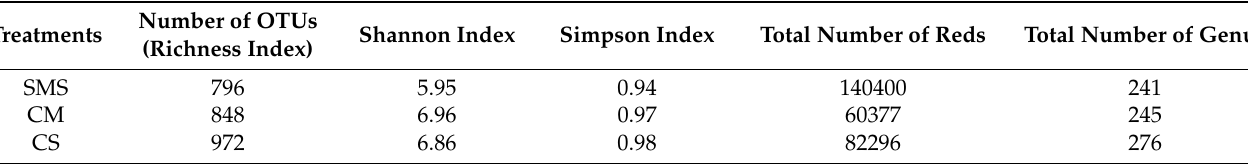
Table 2. Illumina MiSeq sequenced fungal data and fungal community α -diversity indices based on the ITS1 gene at the genus level in soil amended with the spent mushroom substrate (SMS) and chicken manure (CM), and the control soil (CS). Explanations: OTUs, Operational Taxonomic Units. The observed OTUs, Shannon, and Simpson indices were calculated based on data normalized to an equal sequencing depth (at a reading depth of 60,000).